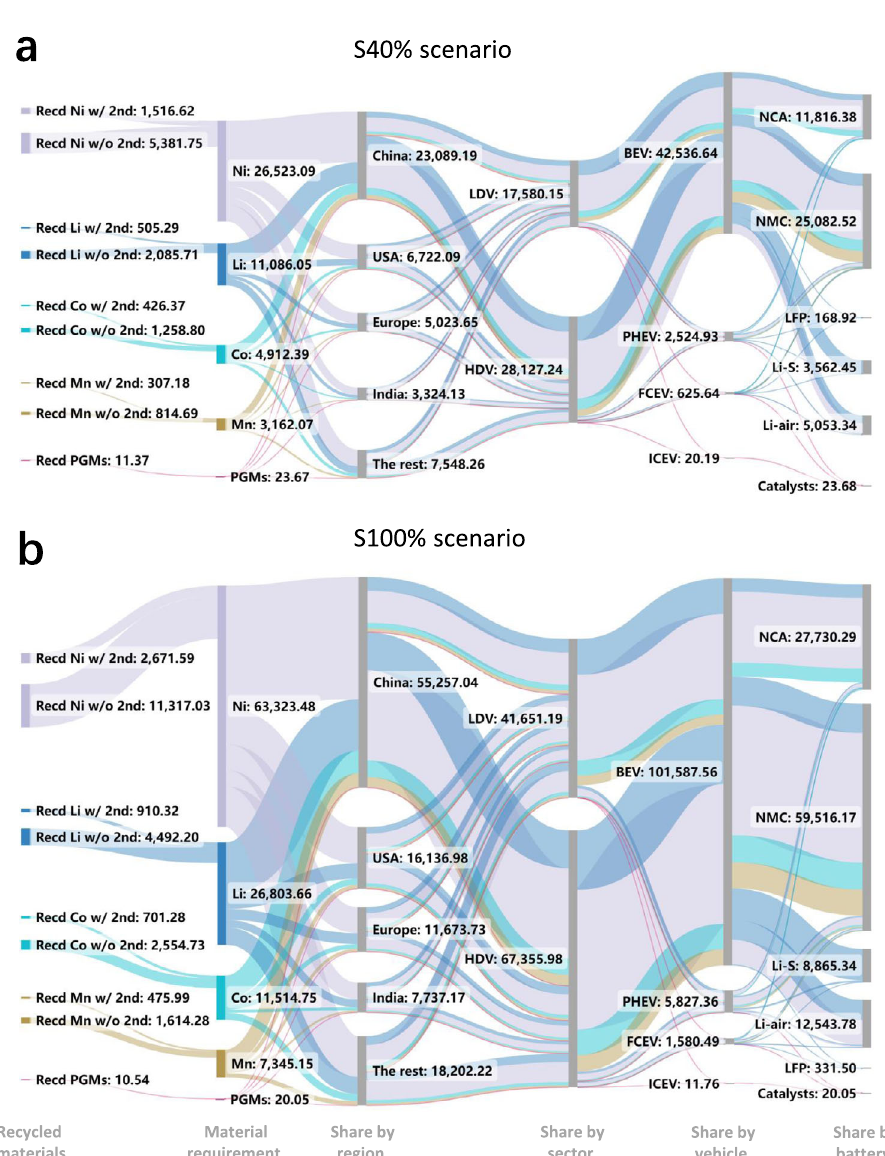
Fig.3|Sankeydiagramsforcumulativecriticalmetalrequirements(Gg)under the 40 and 100% electric vehicle penetration scenarios. a Cumulative